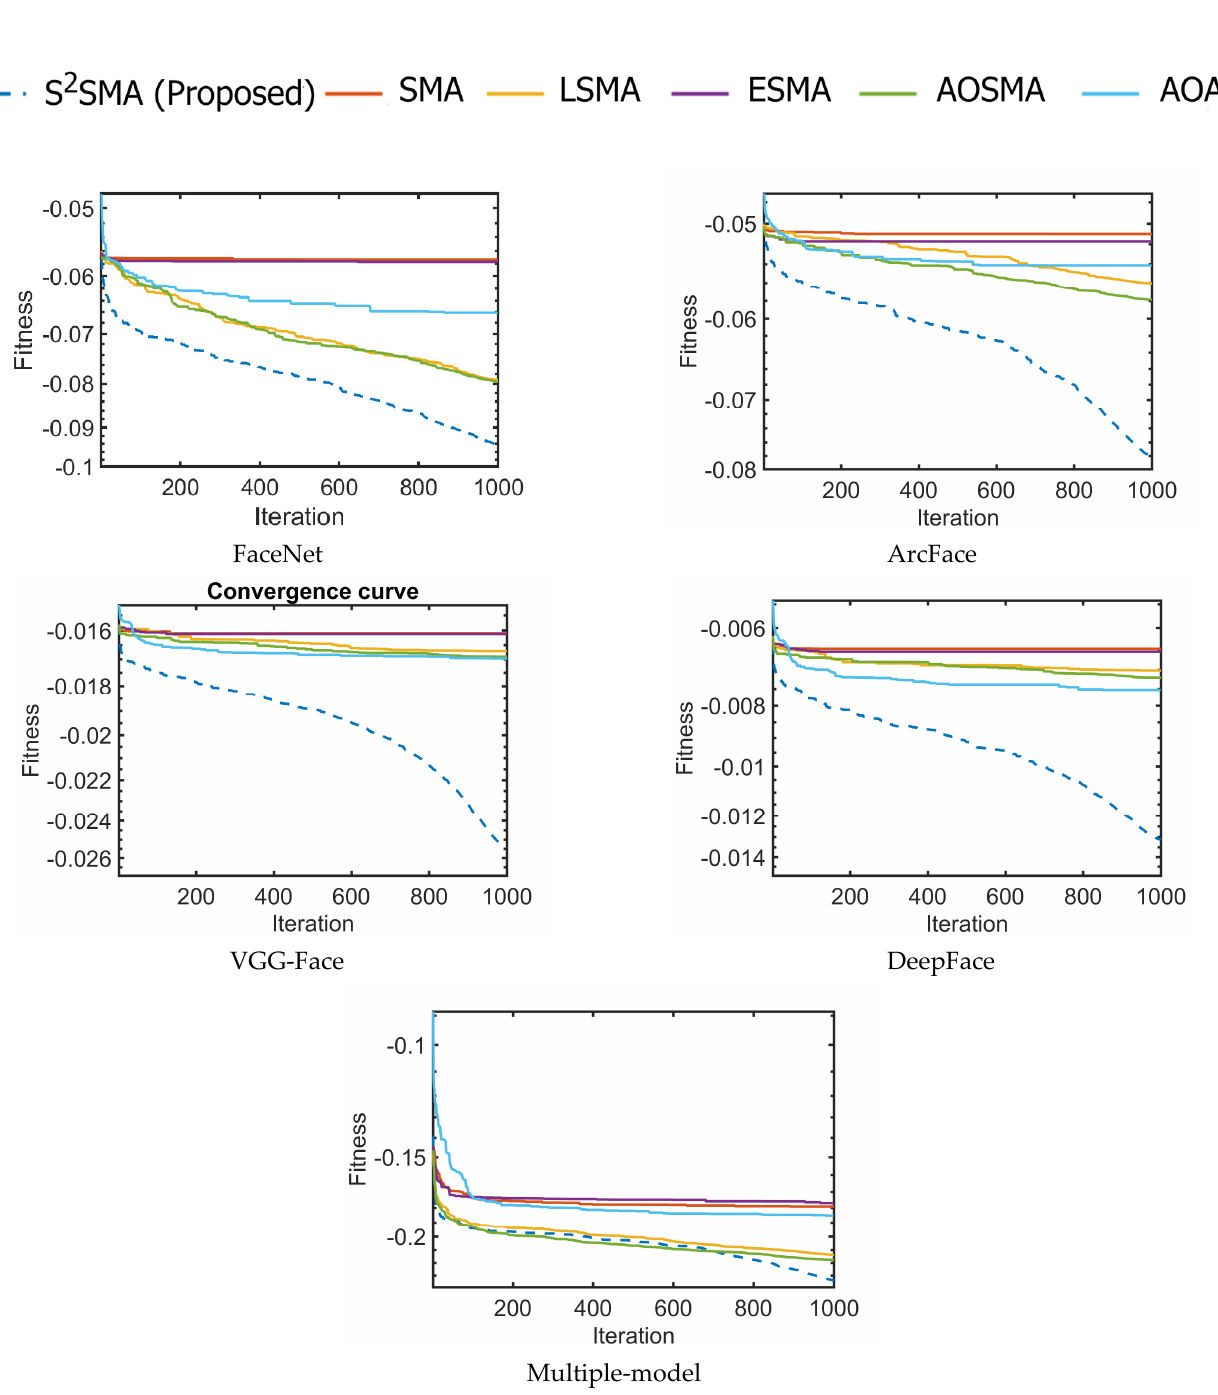
Figure 13. The convergence curves for several single-model and multiple-model approaches. Table 11. p -values for S 2 SMA versus other competitors on